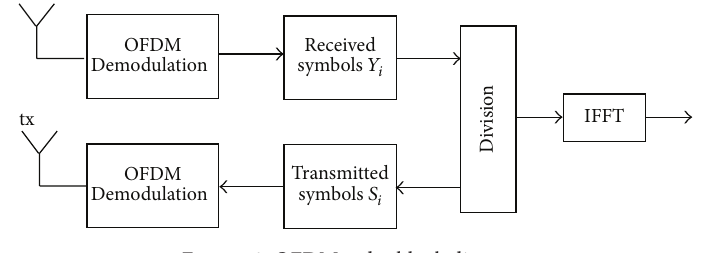
Figure 3: OFDM radar block diagram.